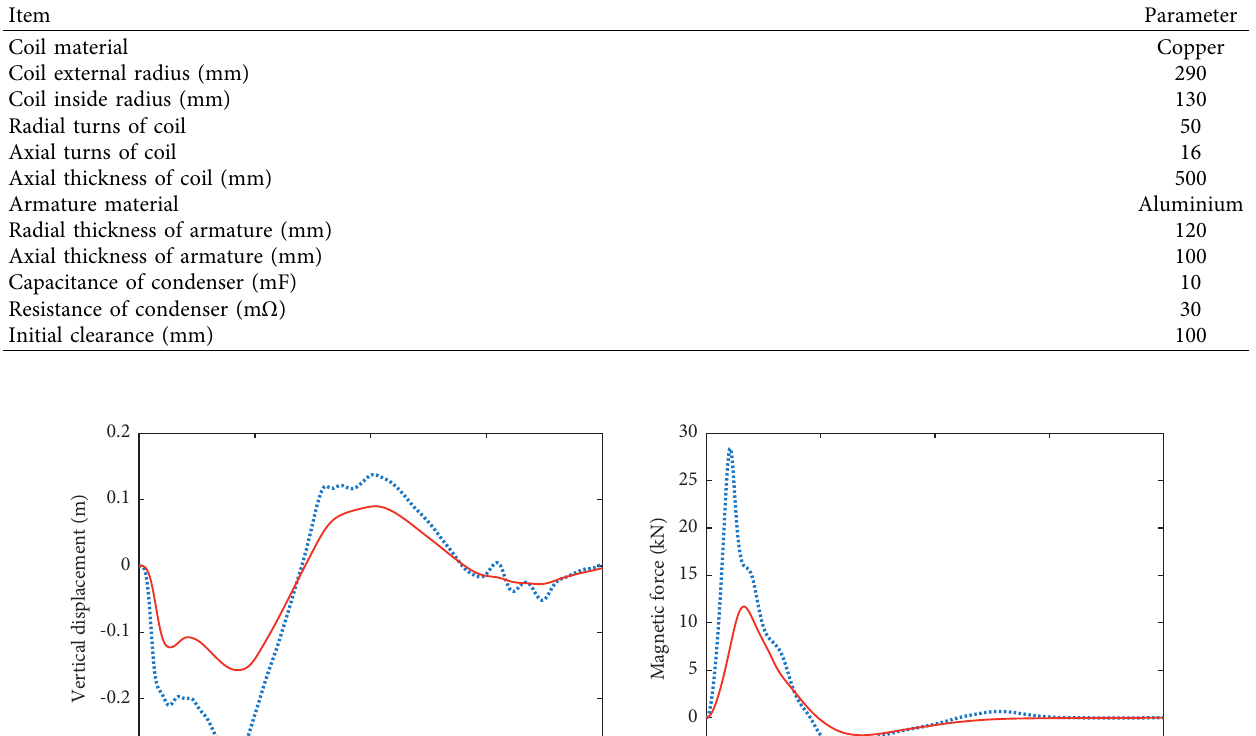
Table 5: Parameters of the electromagnetic excitation device.